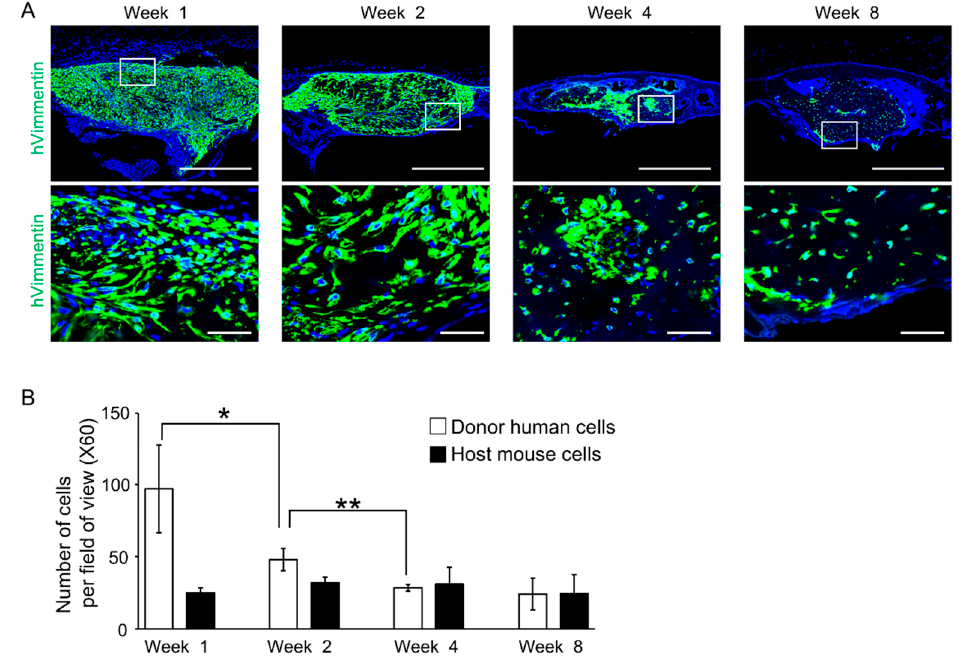
Figure 3. Transplanted human donor and mouse host cells contribute to the bone reconstruction induced by transplantation of C-MSCs. ( A ) Animals were sacrificed at 1, 2, 4, and 8 weeks after surgery and the calvarial bones were fixed. Coronal sections were obtained and immunostained with anti-human Vimentin antibody (green). Nuclei (blue) were counter-stained with DAPI. Upper panels show lower magnification. Bar = 500 µm. Bottom panels are magnifications of the boxed regions. Bar = 50 µm. ( B ) The periphery (left and right), mid (left and right), and center in the bone defect region from each group were used for counting of human vimentin-positive and -negative cells. Results are expressed as means ± SD of the five views tested for each group. * p < 0.05, ** p < 0.01: Values differ significantly. All graphs and images are representative of four independent experiments.